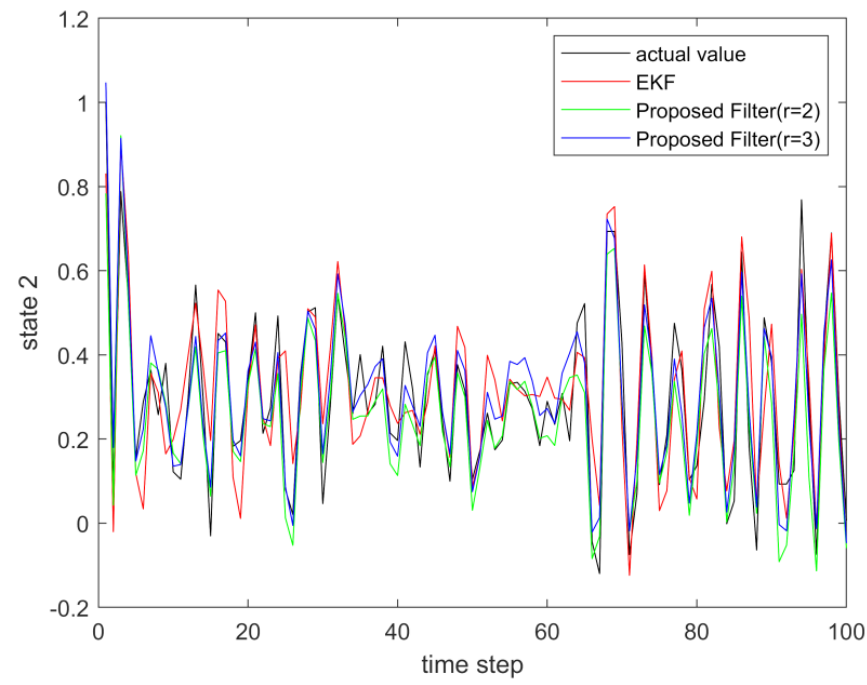
Figure 2. The actual value of state 2 and its estimation.